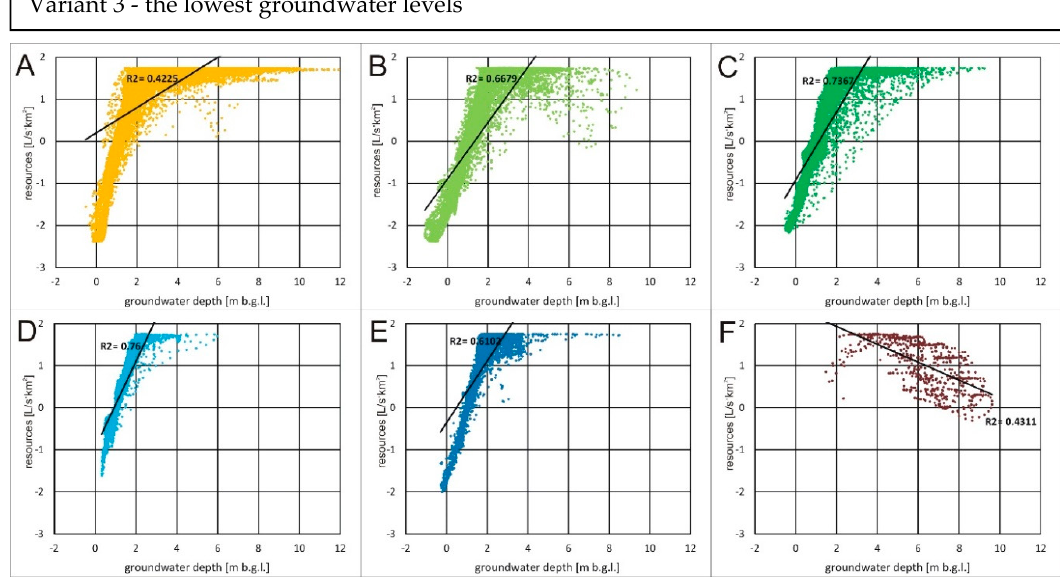
Figure 12. Correlation between groundwater depth and volume of resources in the different variants in geomorphological units: A : Otwock Terrace (I); B : Falenica Terrace (II); C : Praga Terrace (III); D : Higher flood plain (IVa); E : Lower flood plain (IVb); F : Warsaw plain. The correlations were lowest in the variant 3, the lowest level (2003), and amounted to: 0.48 in the Otwock Terrace (I), 0.60 in the Falenica Terrace (II), 0.59 in the Praga Terrace (III), 0.45 in the